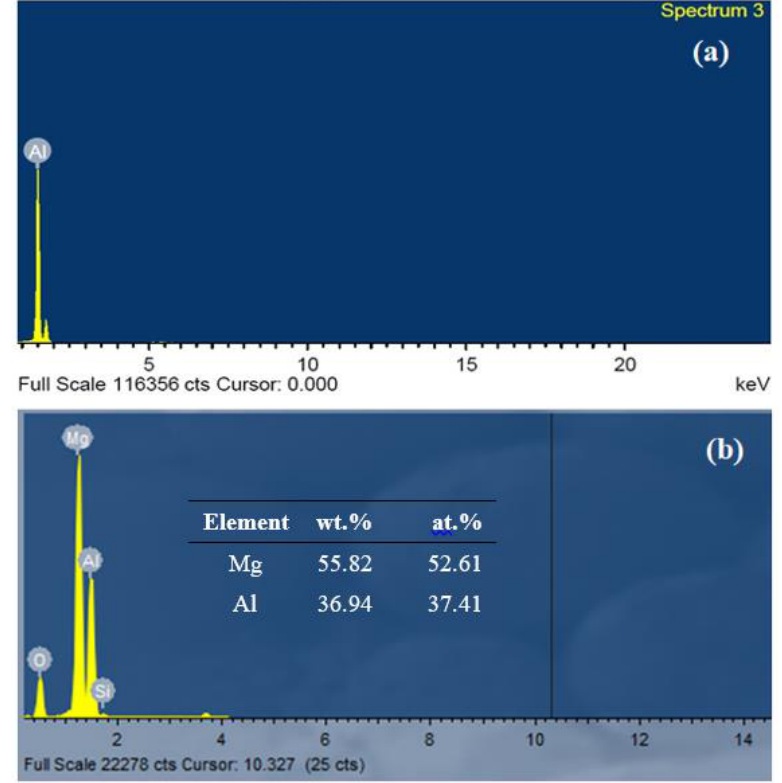
Figure 5. EDX analysis of as-cast ( a ) pure Al and ( b ) Al / Mg-20GMB hybrid composite.